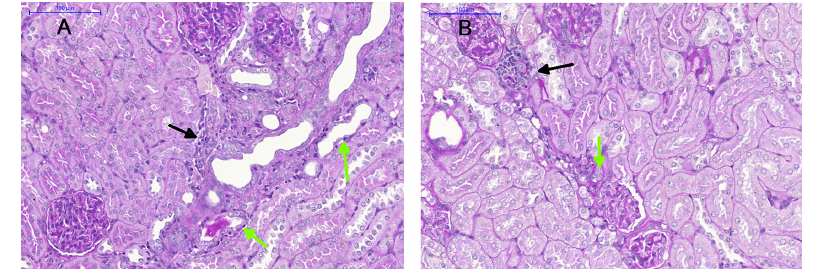
Figure 4. Kidney sections of a control (a) and a stressed (b) male tree shrew. The black arrows indicate inflammatory infiltrating cells, while the green arrows indicate atrophic tubuli. Qualitative analysis did not reveal any indication of stress-induced renal damage. Blue bars represent 100µm.